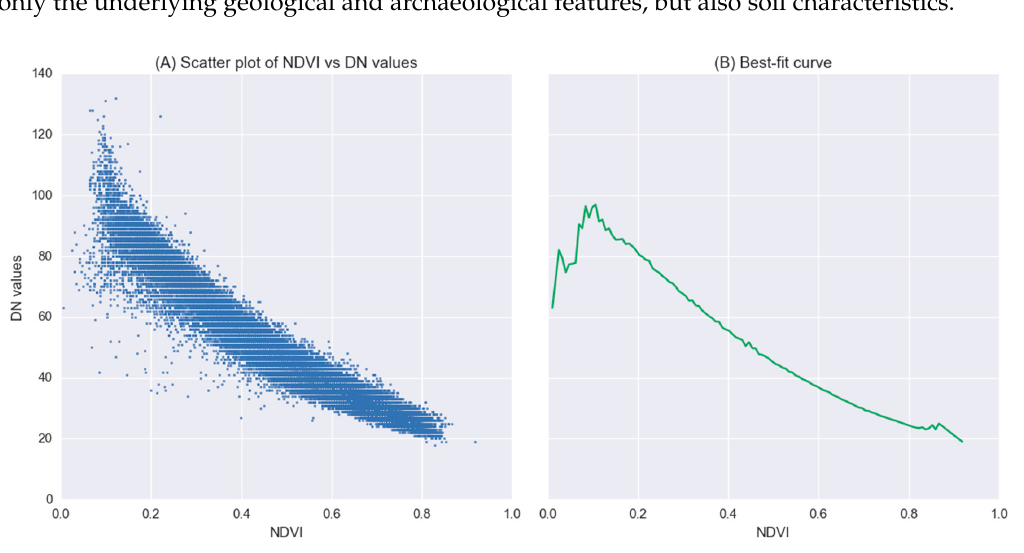
Figure 3. Scatter plot ( A ) and best-fit curve ( B ) of Normalized Difference Vegetation Index (NDVI) and digital number (DN) values.